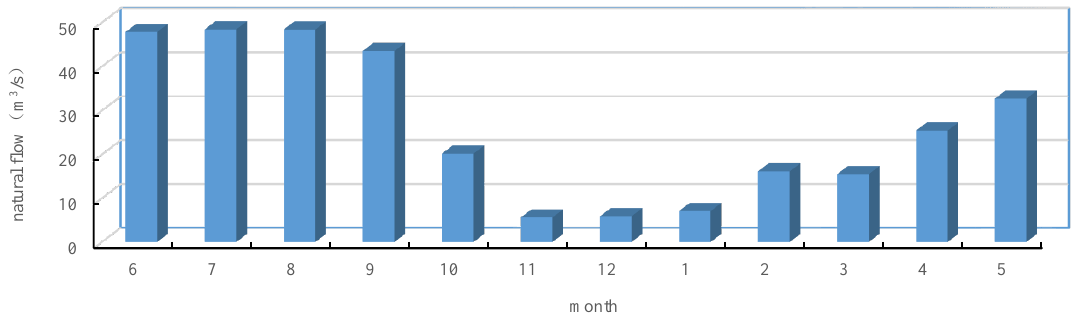
Figure 2. Monthly average runoff process of the Xiaolangdi reservoir.